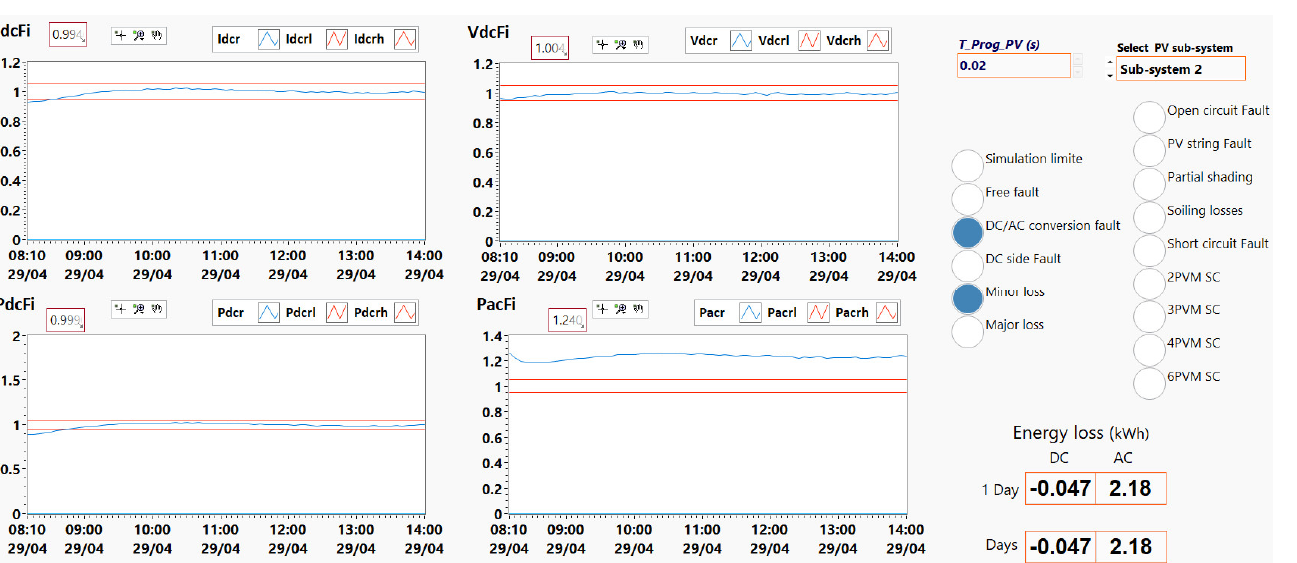
Figure 33. Identification of the four short-circuited PV modules.